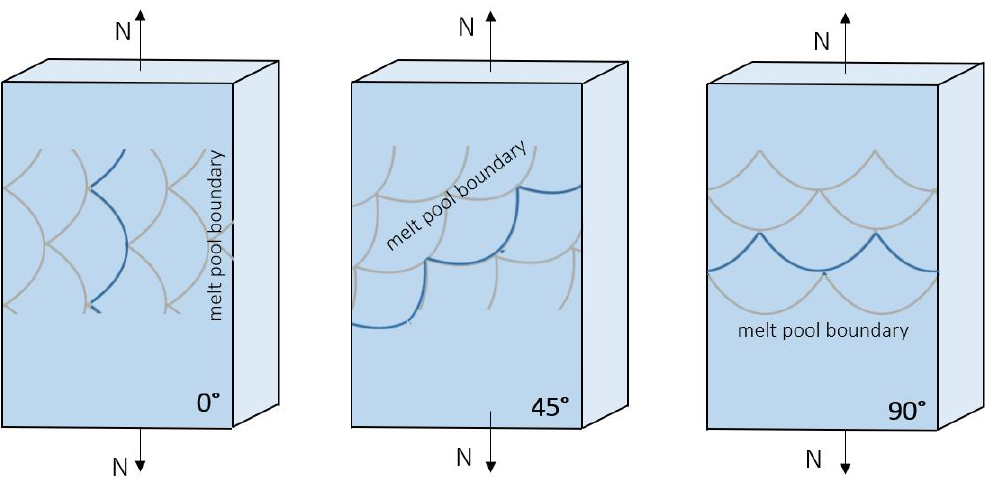
Figure 18. The direction of the melt pool boundary for each build direction respective to the load direction.